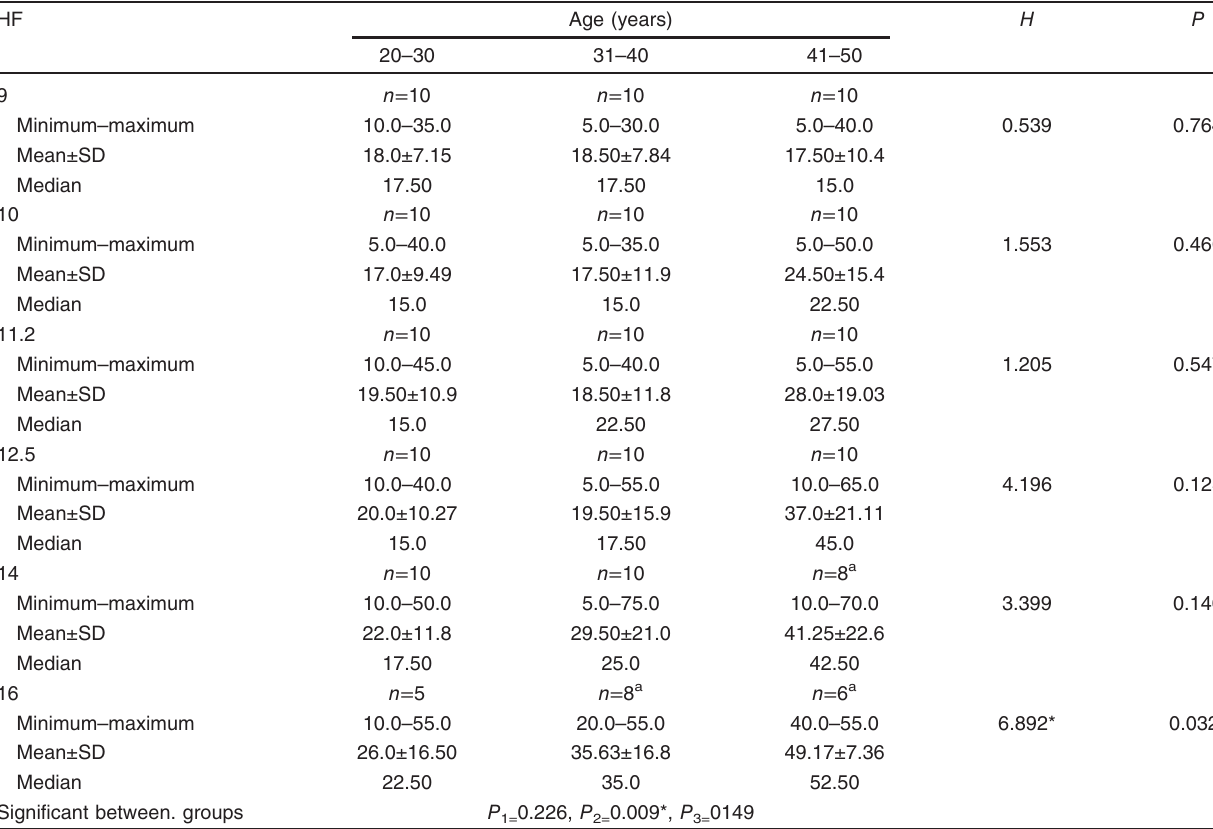
Table 1 High frequency audiometry thresholds at different age groups in the controls